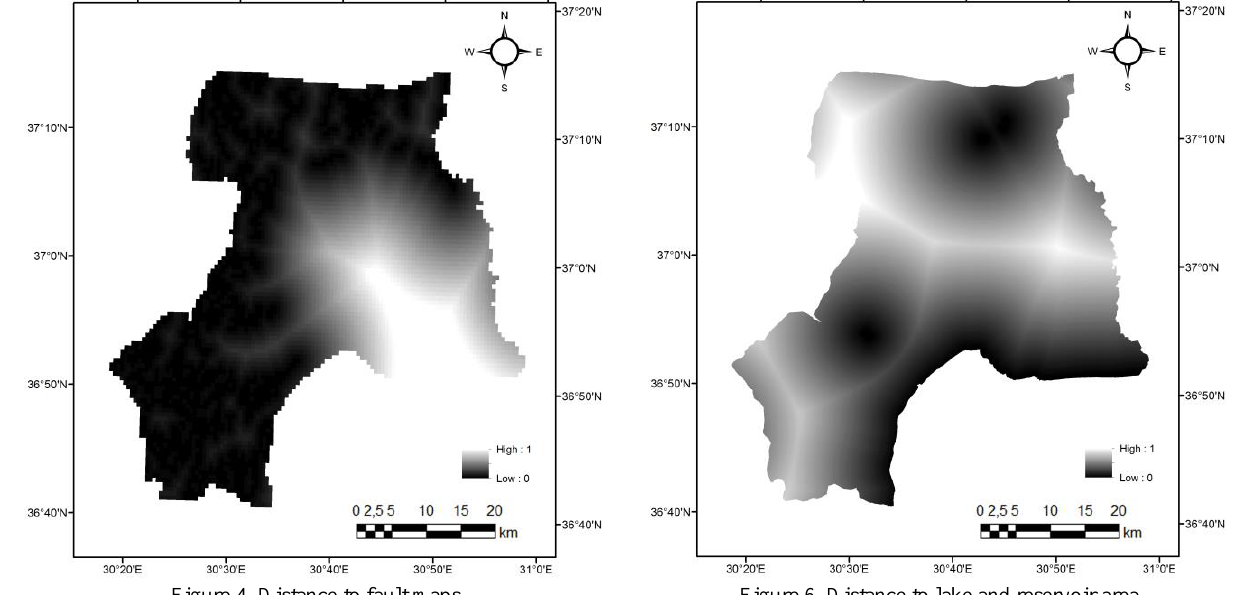
Figure 4. Distance to fault maps